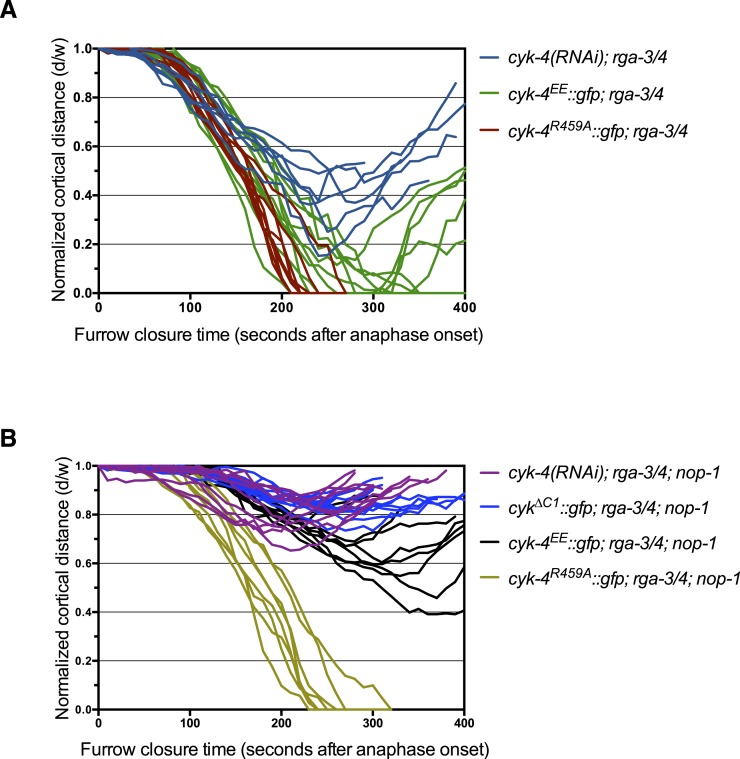
Furrow ingression of RGA-3/4-depleted embryos expressing CYK-4 variants.(A) Line graphs depicting the kinetics of furrow ingression in (A) [cyk-4(RNAi), CYK-4∆C1, CYK-4EE, CYK-4R459A]; nop-1(it142); rga-3/4(RNAi) embryos and (B) [cyk-4(RNAi), CYK-4EE, CYK-4R459A]; rga-3/4(RNAi). These data are summarized in Figure 5C.